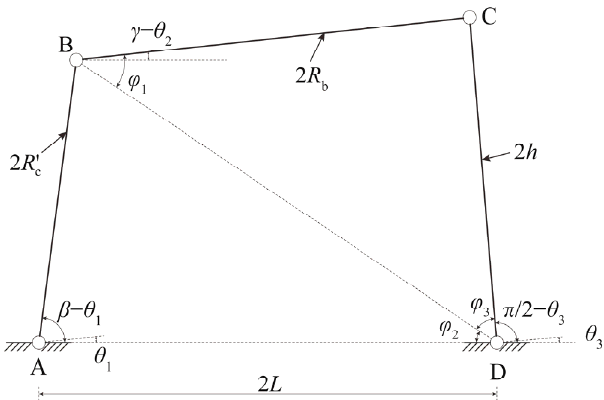
Figure 3. Geometrical relationship of planar four-bar linkage mechanism for θ 1 < 0.